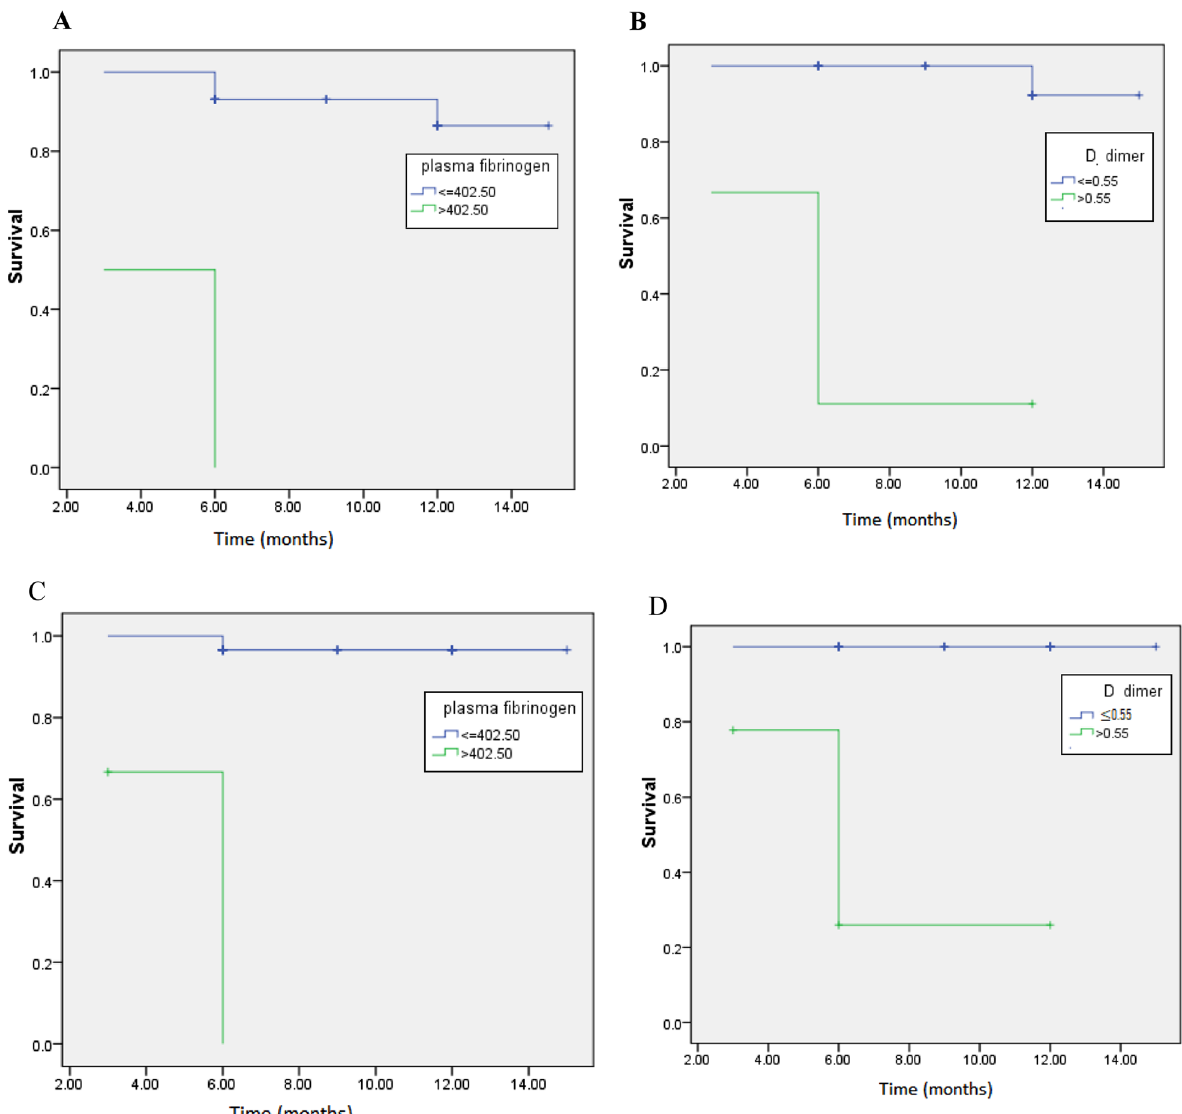
Fig. 2 Kaplan–Meier curves for RFS ( A , B ) and PFS ( C , D ) for NMIBC patients stratified by preoperative plasma fibrinogen and